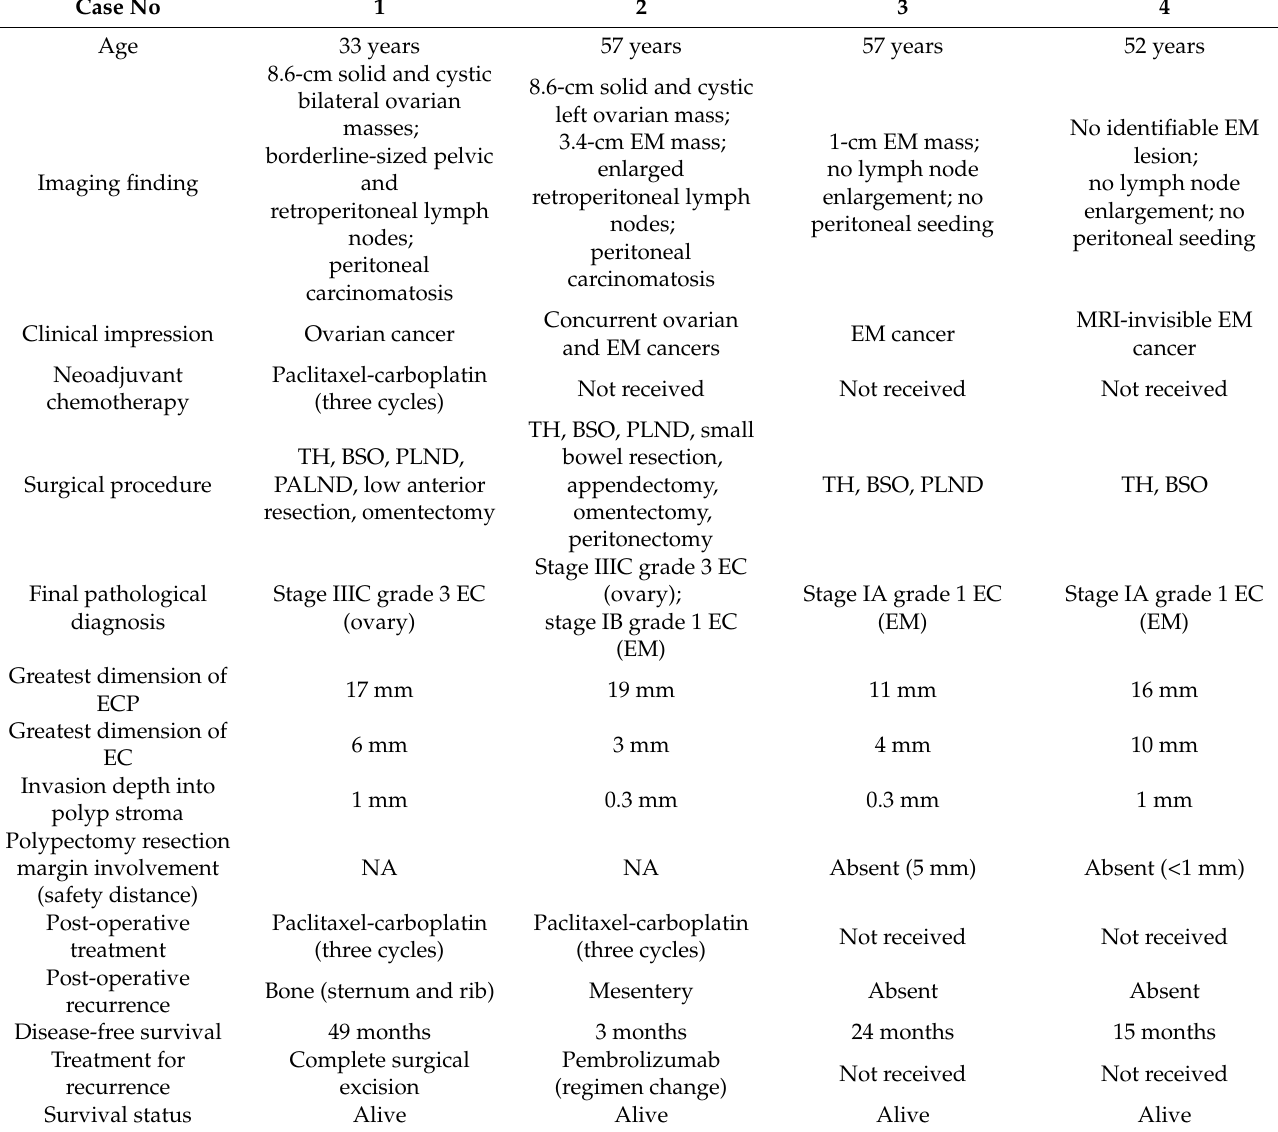
Table 2. Clinicopathological characteristics of four patients with EC involving